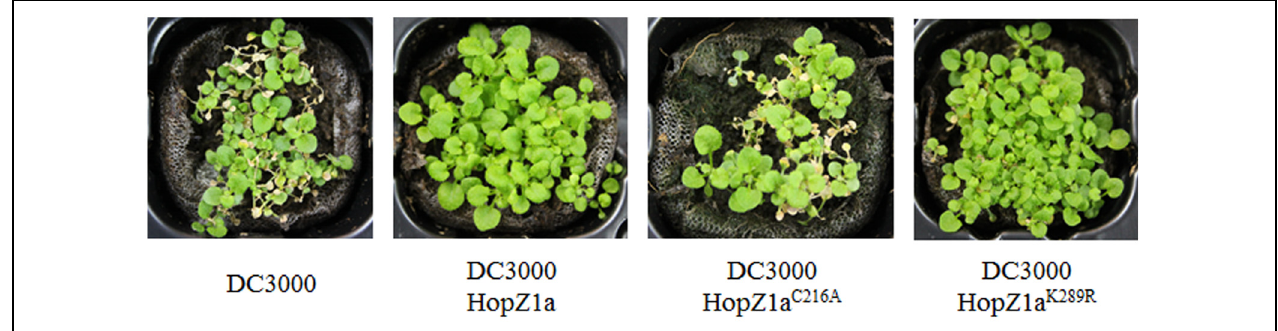
FIGURE 6 | Expression of HopZ1a K289R from DC3000 protects Col-0 plants against disease. Virulence symptoms caused by spray-inoculated DC3000, or DC3000 expressing HopZ1a (pAME30), or each of its mutant derivatives HopZ1a C216A (pAME27) or HopZ1a K289R (pMAM1). Arabidopsis